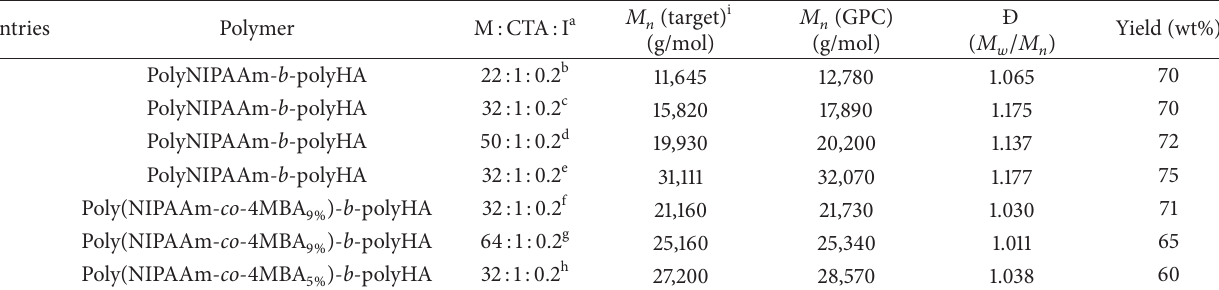
Table 2: Preparation of linear block copolymer arms.